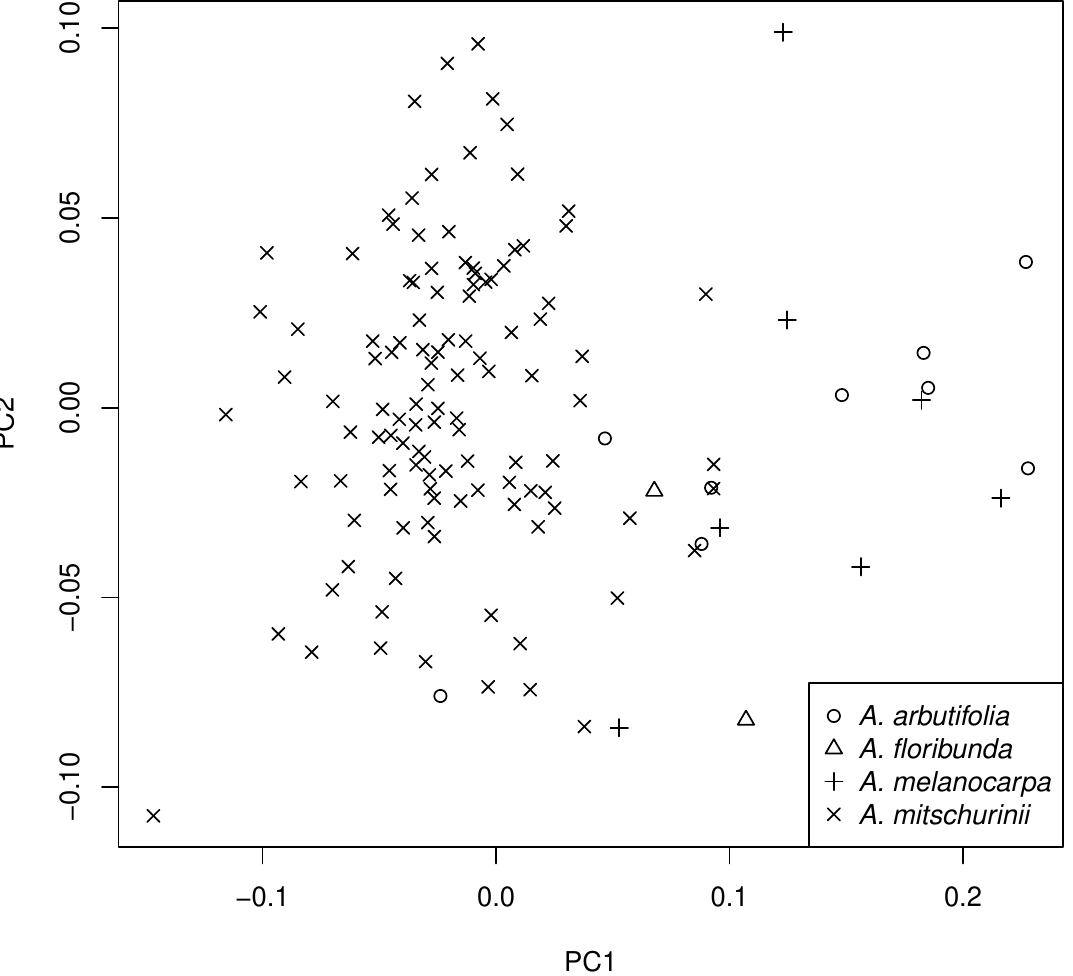
Fig. 8. Ordination from the principal component analysis of relative